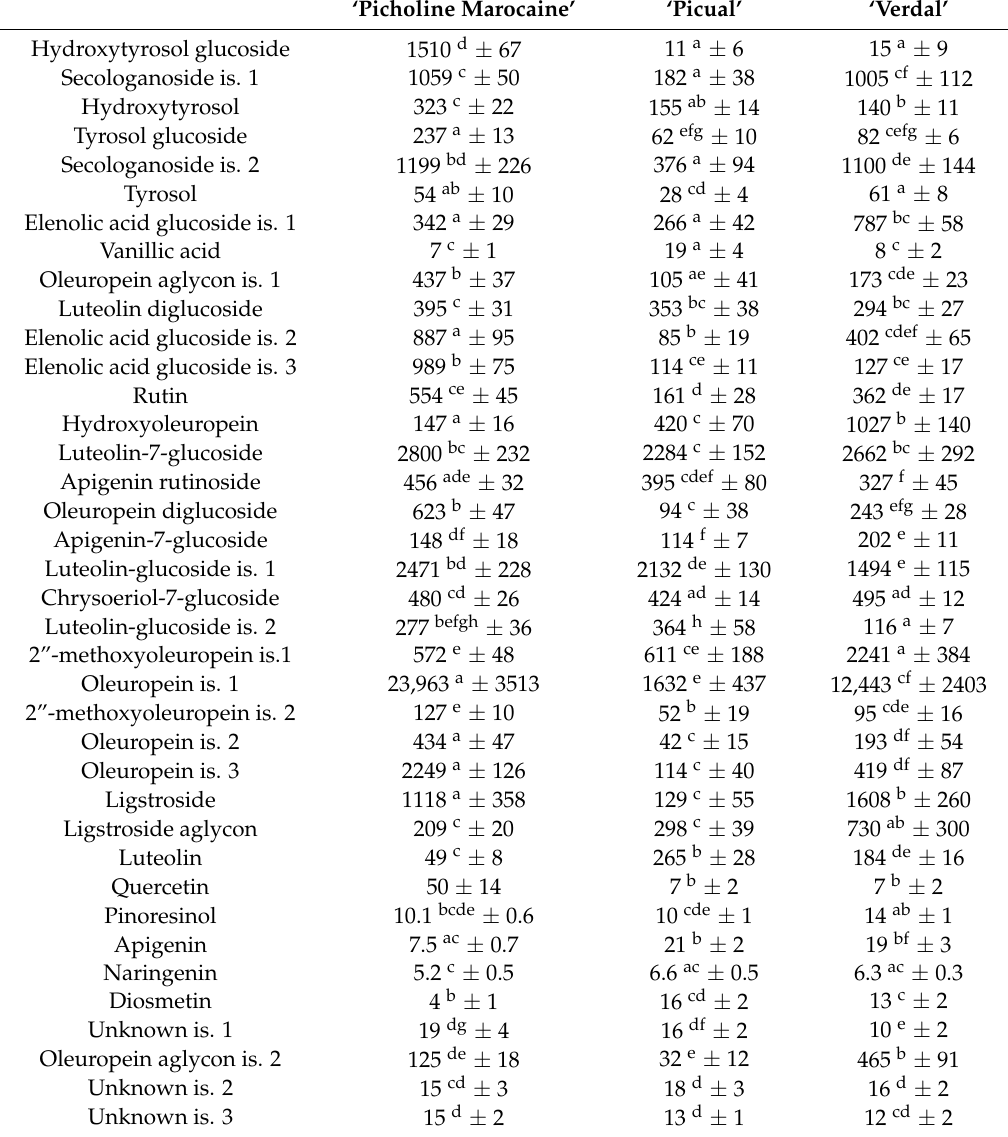
Table 4. Found content (average values and standard deviation, mg/kg DW) of the determined phenolic compounds in the evaluated olive leaves cultivars. ANOVA results are included; significant differences in the same row are indicated with different superscript letters (comparison among the 11 cultivars investigated in this study, p <